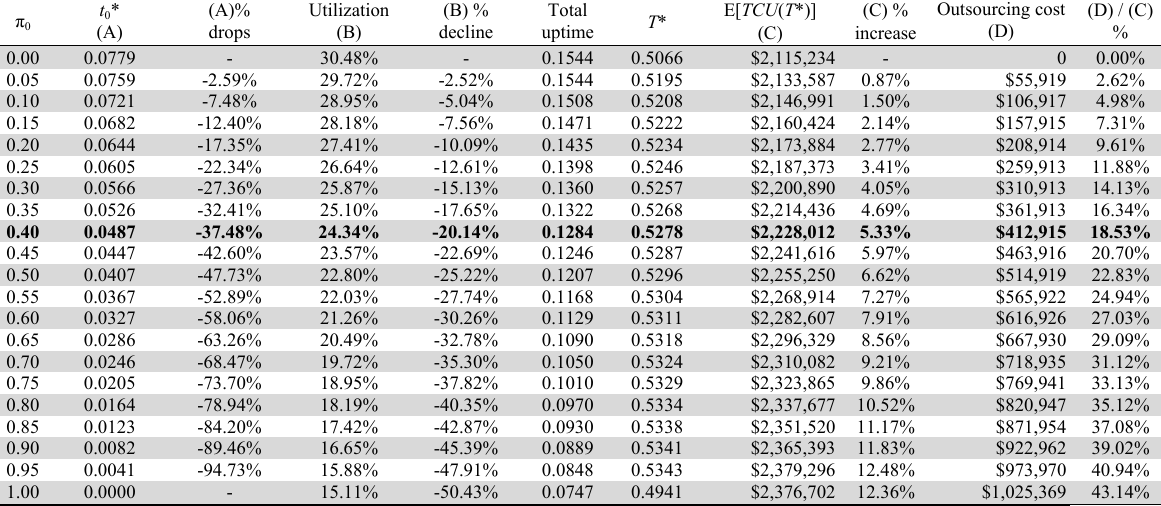
Impact of differences in π 0 on system’s utilization & various related parameters π